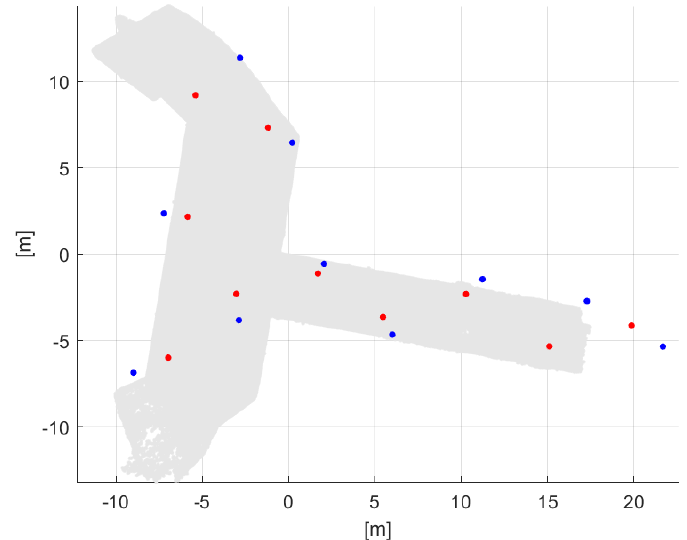
Figure 6. Pozyx anchor positions during survey in the Impossible bastion estimated with respect to PhotoScan 3D model (local coordinate system): surveyed with Leica TCR 702 Total Station (red dots); estimated with self-positioning of Pozyx anchors (blue